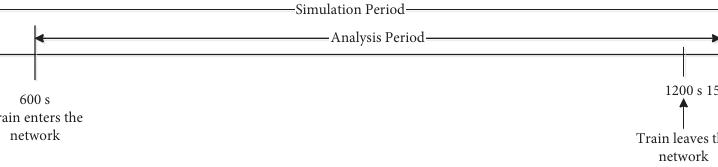
Figure 8: Time frame for analysis period during the sensitivity